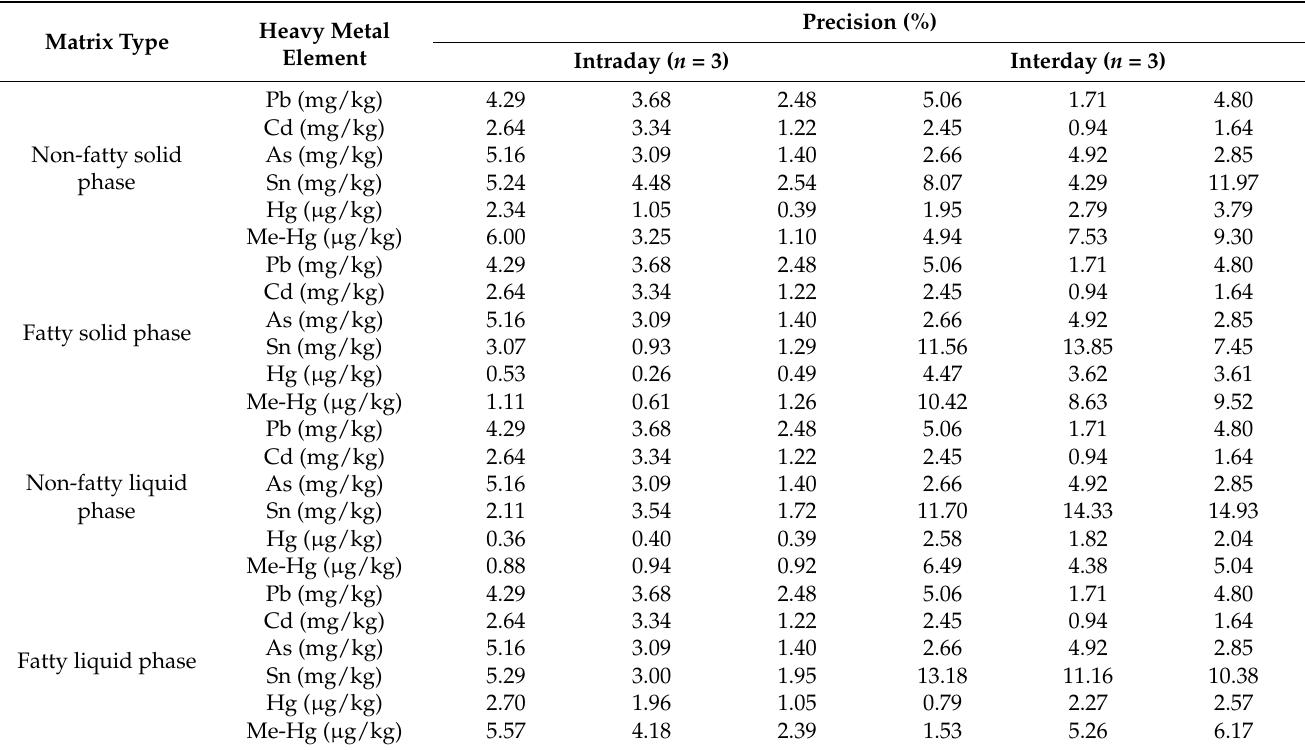
Table 3. Precision of analysis (% CV) of the six heavy